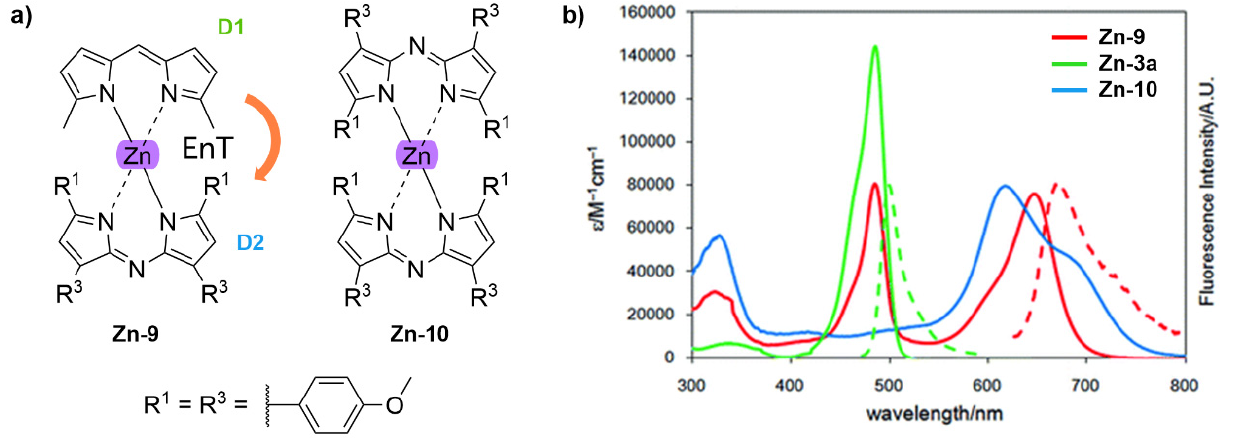
Figure 20. ( a ) Chemical structures and ( b ) UV-Vis absorption (solid line) and fluorescence (dashed line) spectra of Zn-9 , Zn-3a and Zn-10 . ( b ) is reproduced with permission from [120]. Copyright © 2012 Royal Society of